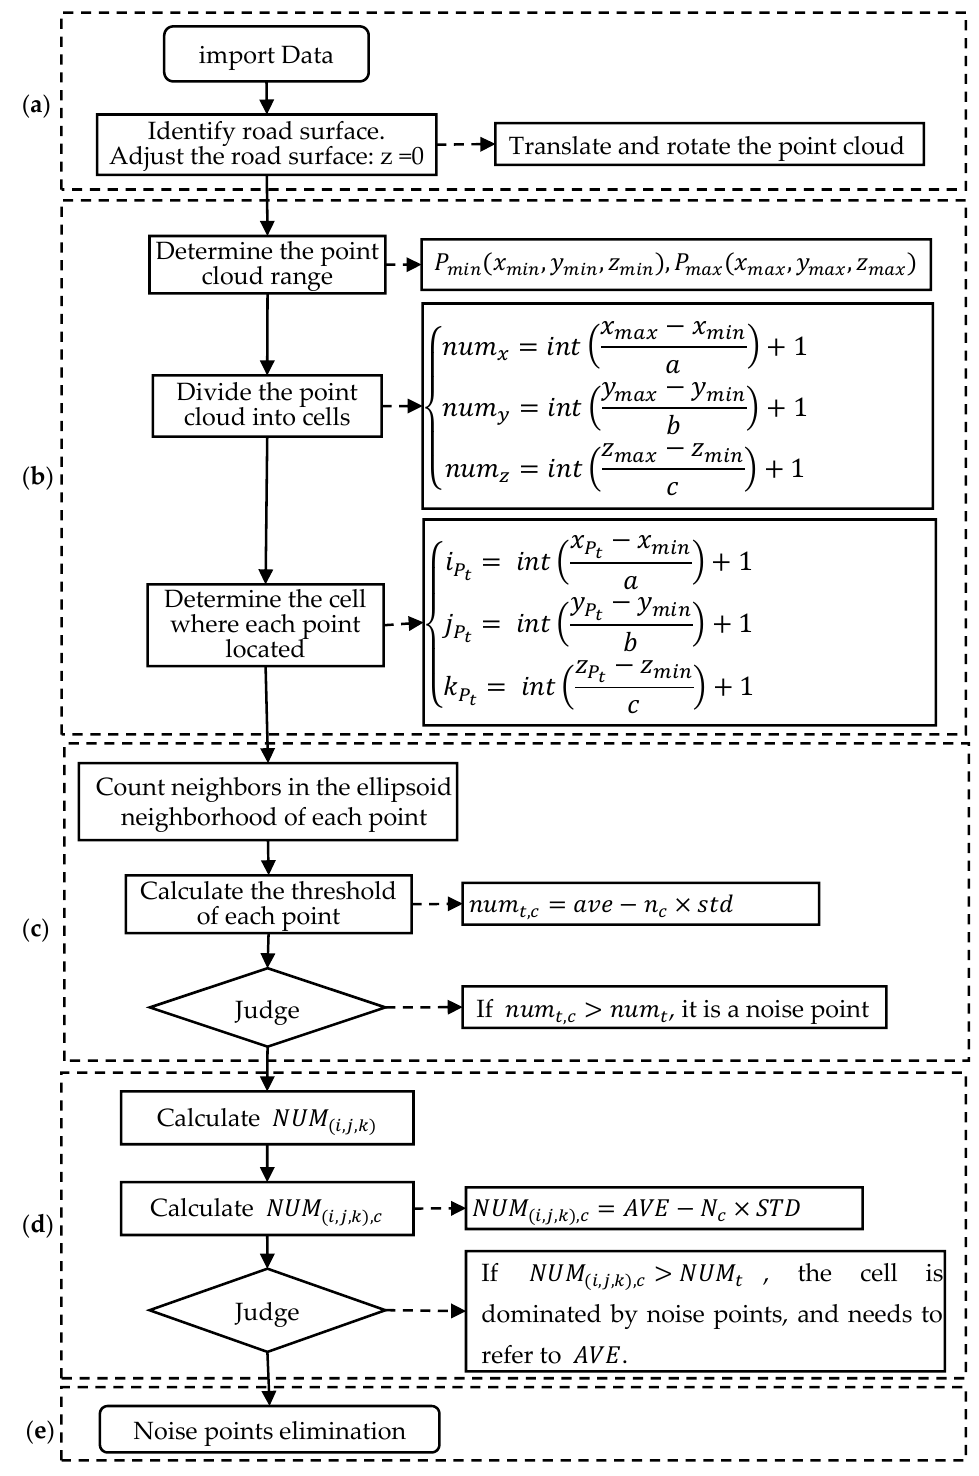
Figure 1. The flow chart of pavement point cloud denoising algorithm based on cell meshing ellipsoid detection: ( a ) Preparation stage; ( b ) cell meshing the point cloud and pre-denoising; ( c ) Denoising by ellipsoid detection; ( d ) Comparison between cells; ( e ) Noise points elimination.